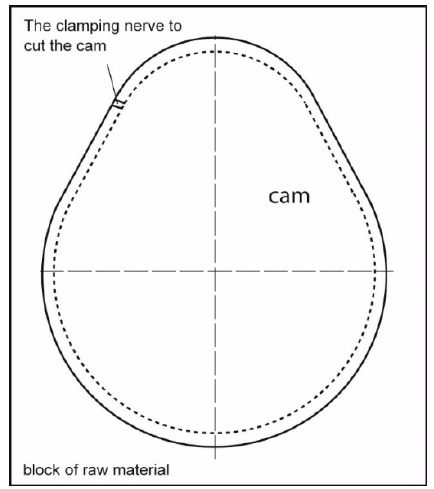
Figure 12. Detail of the required clamping nerve of the WEDM cam.